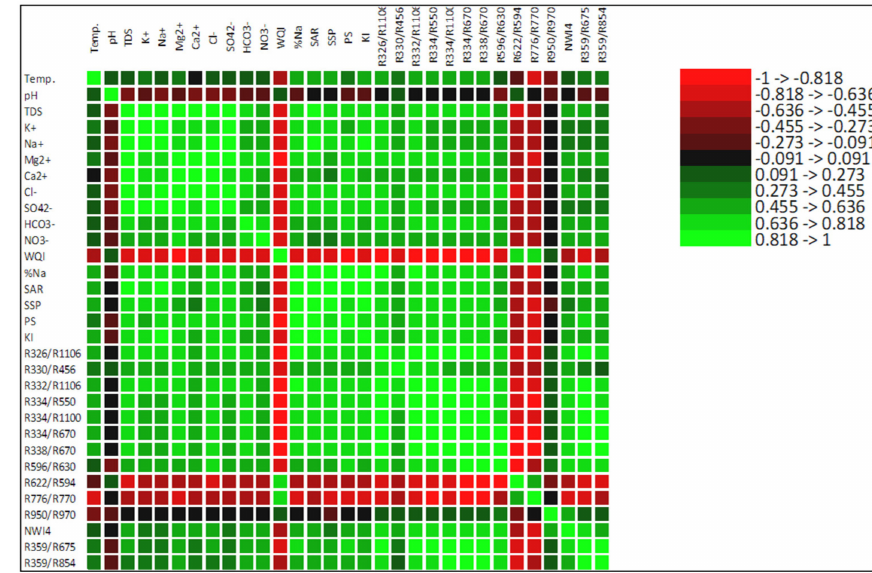
Figure 7. Correlation matrix of spectral reflectance indices with physicochemical parameters and irrigation water quality indicators: irrigation water quality (IWQ), percent sodium (%Na), sodium absorption ratio (SAR), soluble sodium percentage (SSP), potential salinity (PS), and Kelly’s index (KI) across the Western Desert and Central Nile Delta ( n =